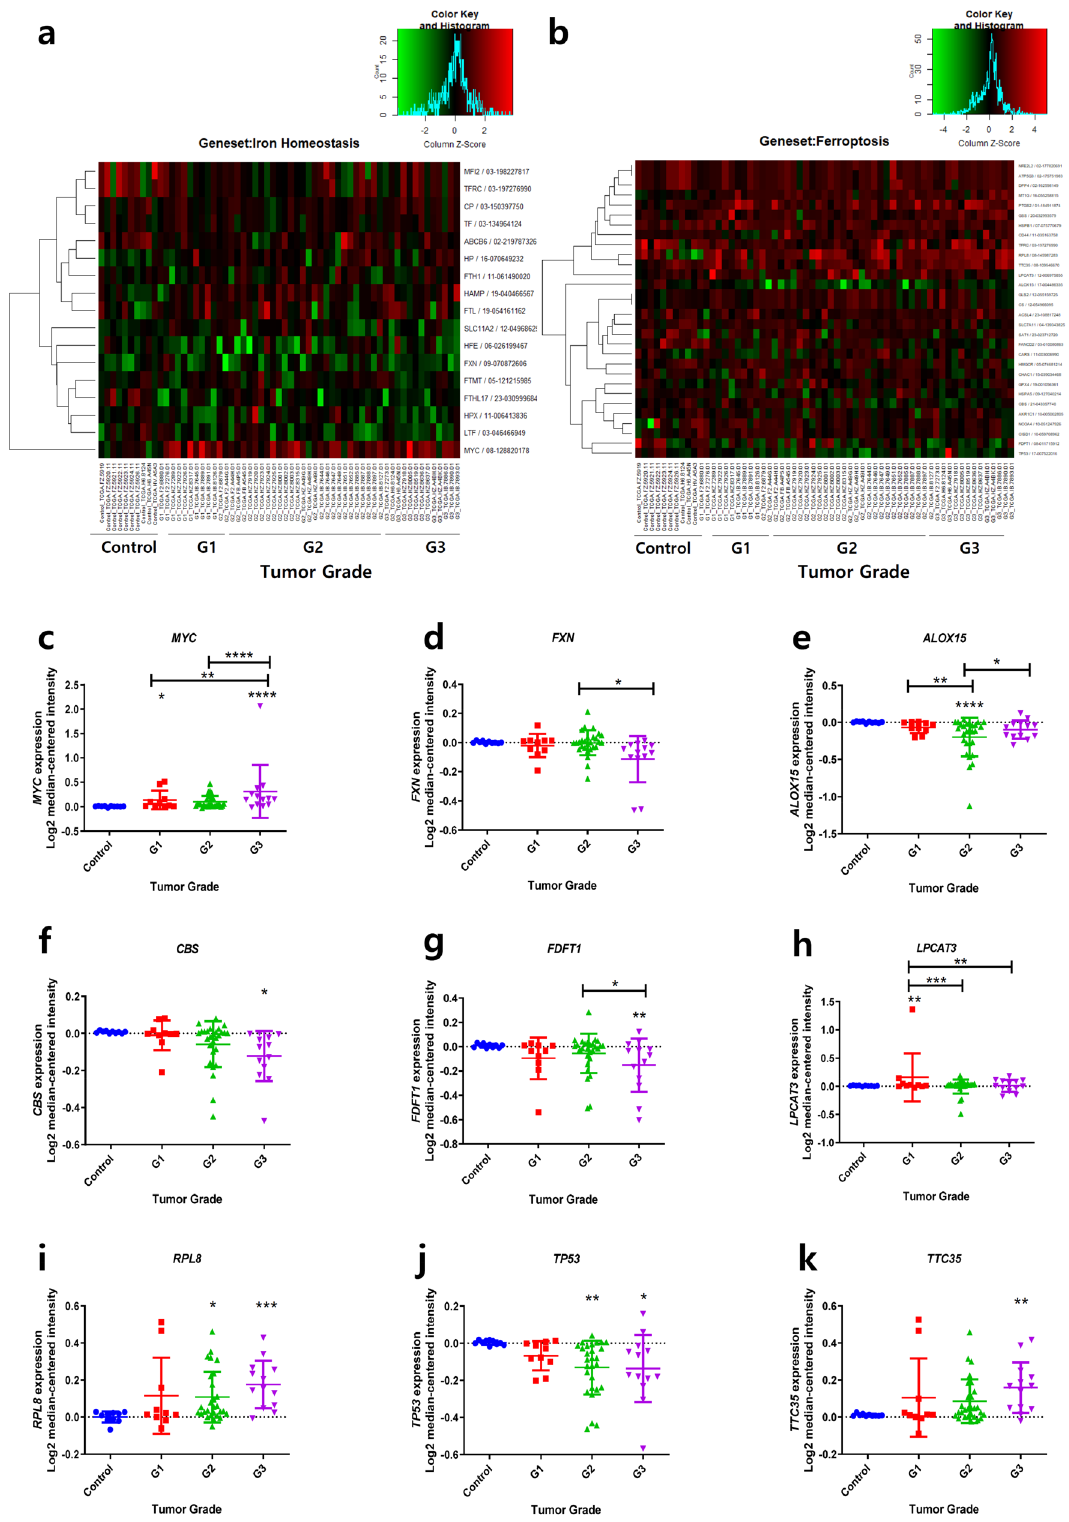
Figure 4. Analysis of pancreatic cancer patient gene expression data responsible either iron homeostasis signaling or ferroptosis. Heatmaps for gene expressions of ( a ) iron homeostasis signaling and ( b ) ferroptosis was created using R Studio 3.5.3. 33 using the package of heatmap.plus (ver. 1.3) 34 on TCGA pancreatic cancer dataset. Differential gene expressions in 10 normal tissues and 51 tumor tissue samples at different histological grades (G1: n = 10, G2: n = 28, G3: n = 13) are calculated based on the Z-score showing an up-regulation (red) and down-regulation (green) clustered in heatmaps. Columns represent each sample. ( c , d ) Iron homeostasis genes and ( e – k ), ferroptosis regulatory genes were differentially expressed with histologic tumor grade of pancreatic cancer. Only genes that reached statistical significance are reported. * p < 0.05, ** p < 0.01, *** p < 0.001, and **** p < 0.0001 as determined by a two-way ANOVA with Tukey’s post-hoc